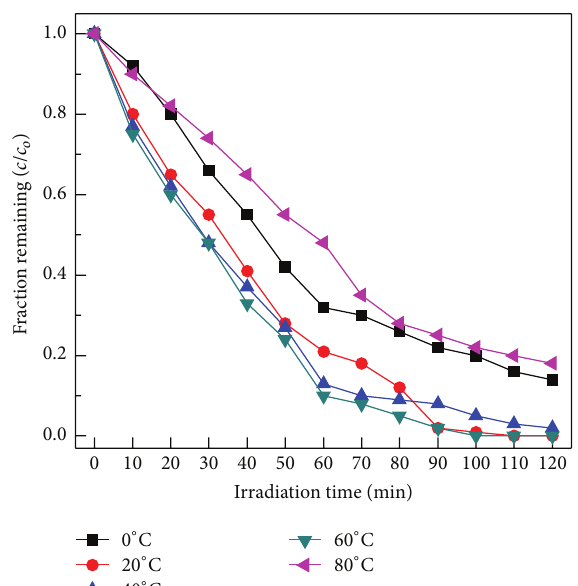
Figure 7: Removal efficiencies of RhB in the presence of 1.2% G-BWO at different temperature under visible light irradiation (catalyst dosage: = 10ppm; pH 7). 1g/L; c o